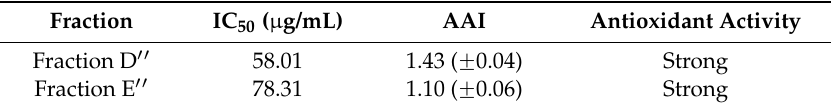
Table 3. Antioxidant activity index (AAI) values for fractions of the acetone extract from citrus by-products.